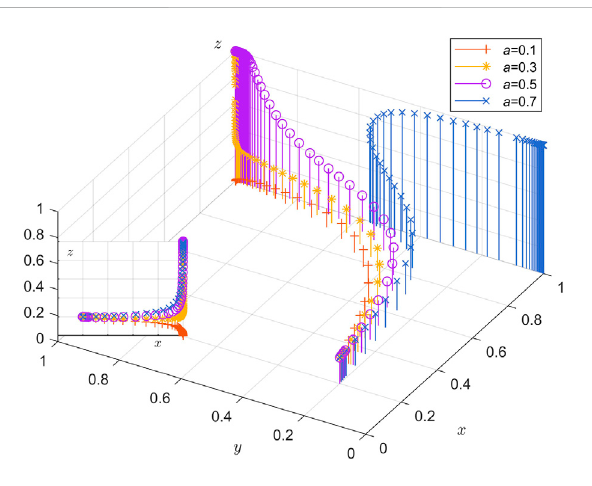
FIGURE 13 In fl uence of coef fi cient a on the evolution of stakeholder behavior.